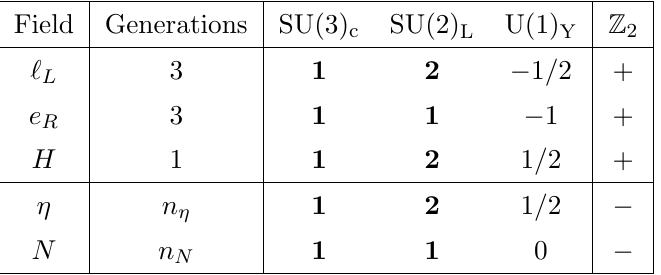
Table 1 . Scalar and fermion particle content of the model and representations under the gauge and global symmetries. ‘ L and e R are the SM left- and right-handed leptons, respectively, and H is the SM Higgs